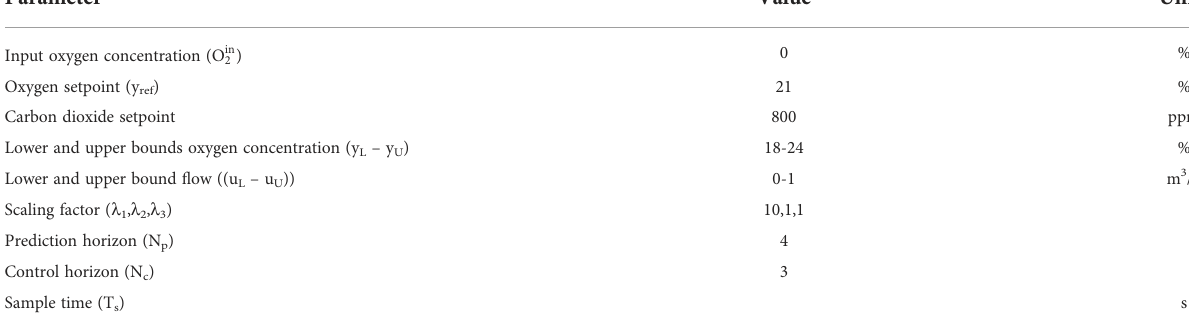
TABLE 5 Controller speci fi cations including SSTO and MPC